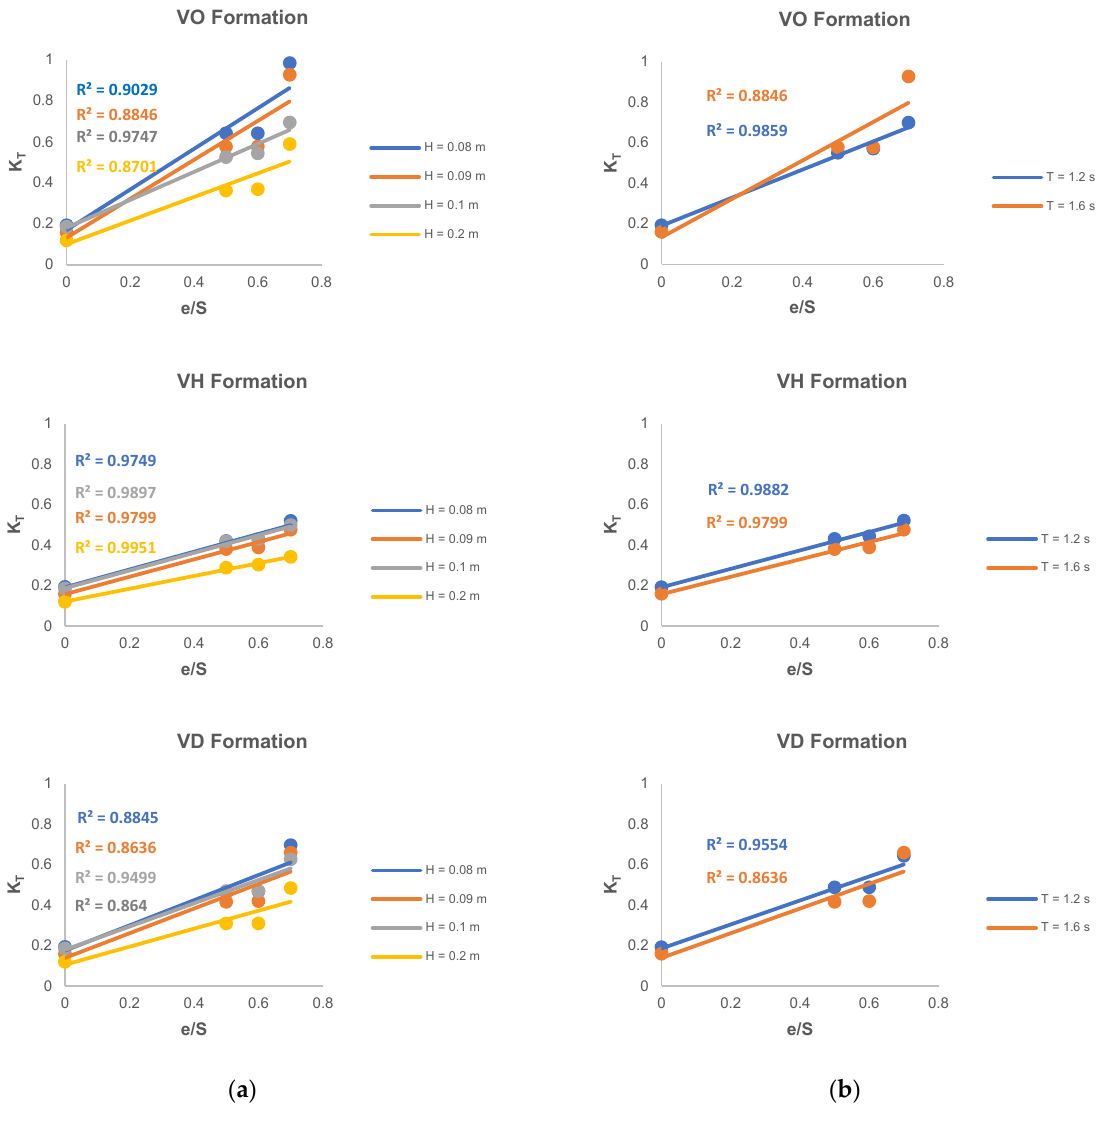
Figure 5. The influence of the e/S ratio on the transmission coefficient is distinguished by ( a ) the wave height and ( b ) the wave period for three bamboo formations.